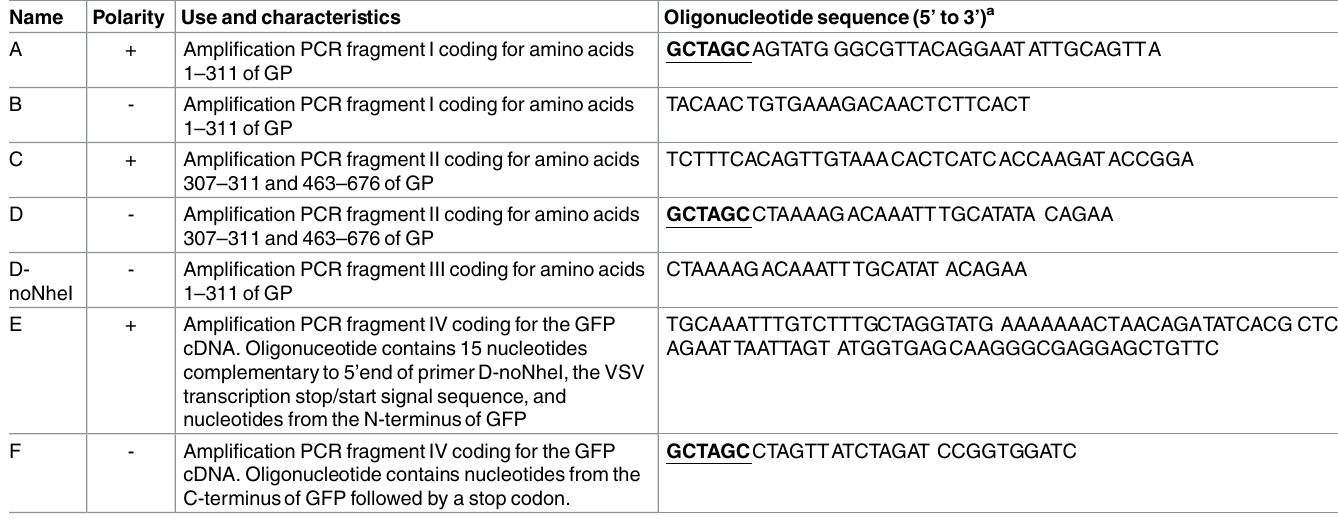
Table 1. Oligonucleotidesused in plasmid